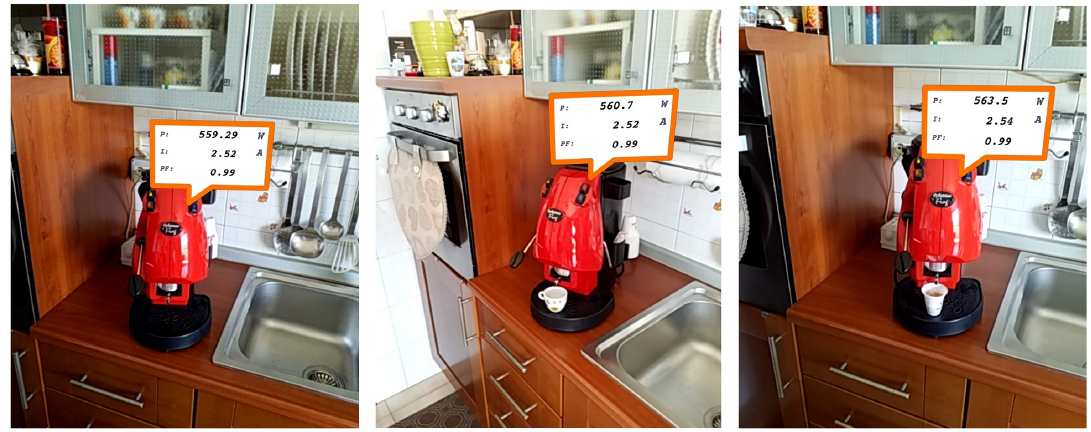
Figure 16. Screenshots of the realized app while rendering power measures in AR.